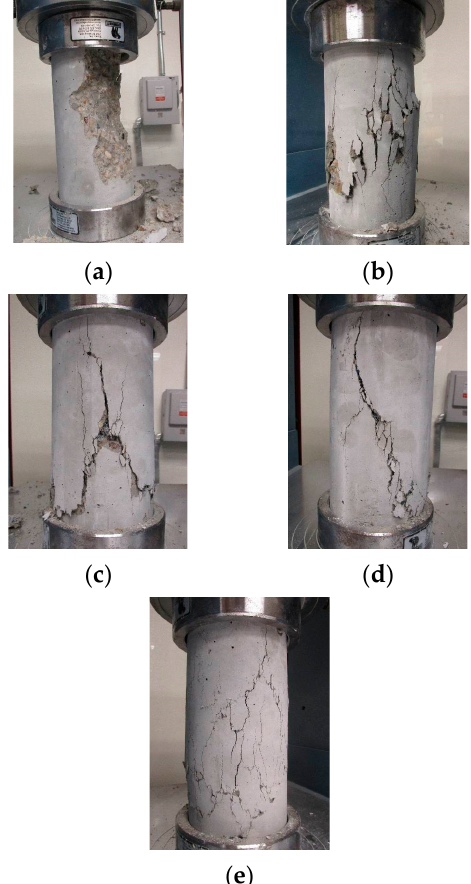
Figure 15. Modes of failure of concrete specimens with different CR contents. ( a ) 0% content of CR. ( b ) 5% content of CR. ( c ) 10% content of CR. ( d ) 15% content of CR. ( e ) 20% content of CR.